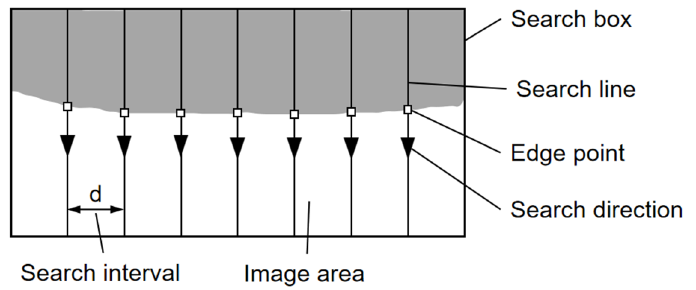
Figure 8. Schematic diagram of the edge search box.